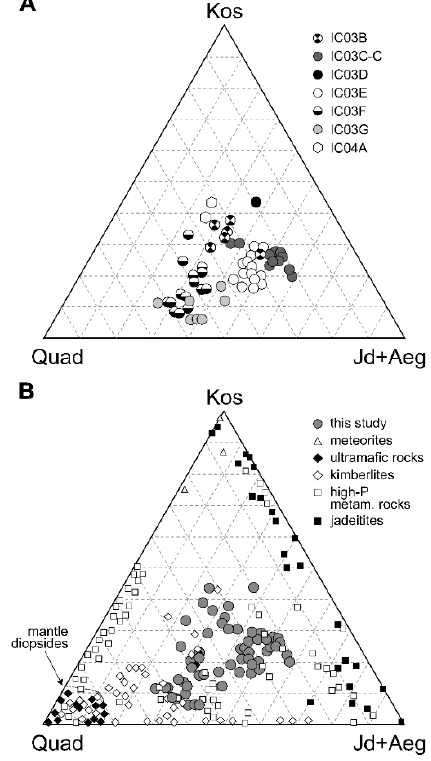
Figure 4. ( A ) Ternary diagram of Na–Cr-rich pyroxene grains from this study. ( B ) Ternary plot of data for Na–Cr-rich pyroxenes from this study and published compositions [15,26,27]. The published data also include kimberlite and peridotite xenoliths enclosed in basaltic host rocks. Quad represents sum of Ca + Fe + Mg pyroxenes [1].